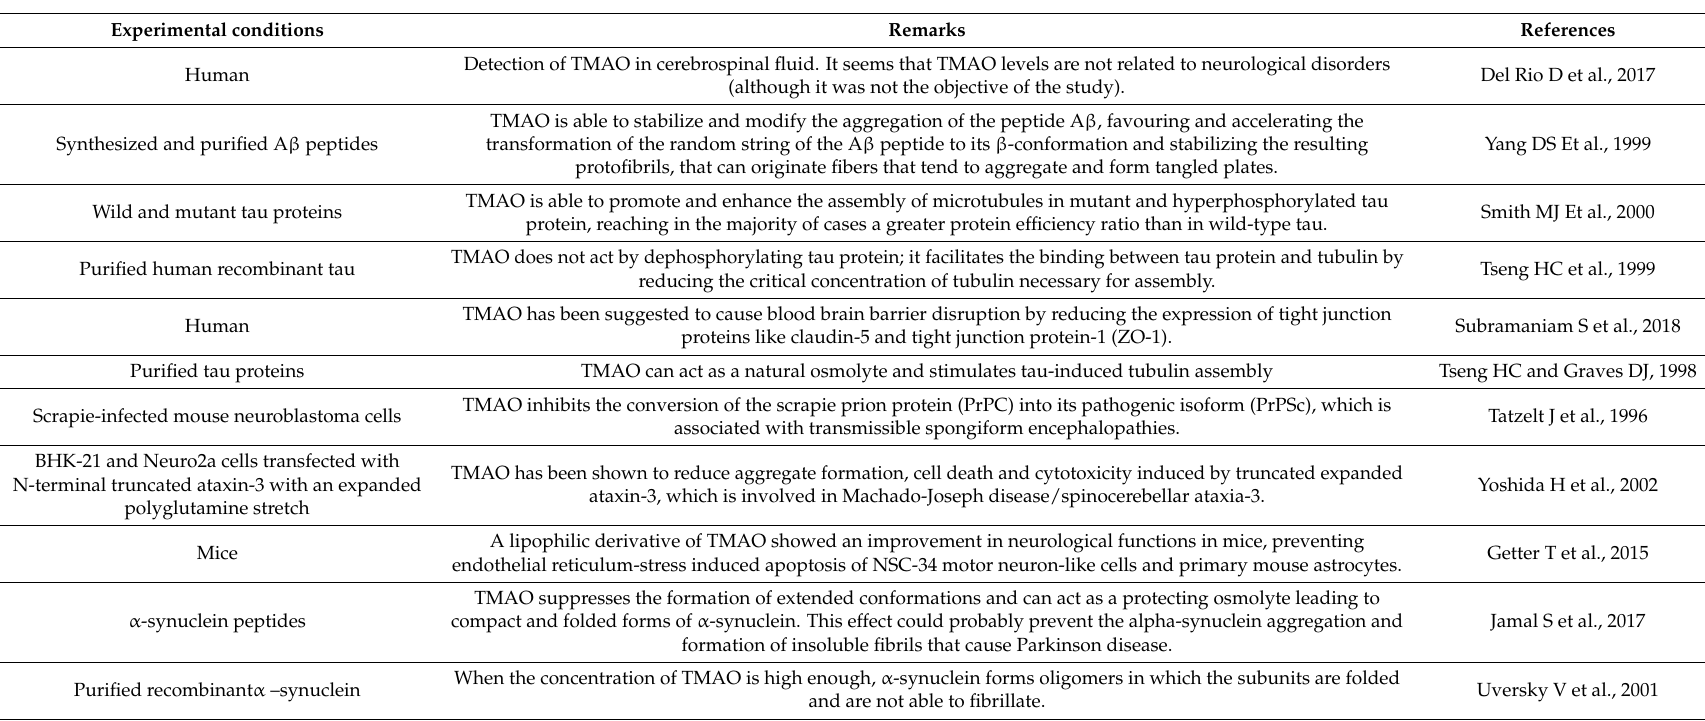
Table 3. Relationships between neurodegenerative disorders and TMAO in different experimental